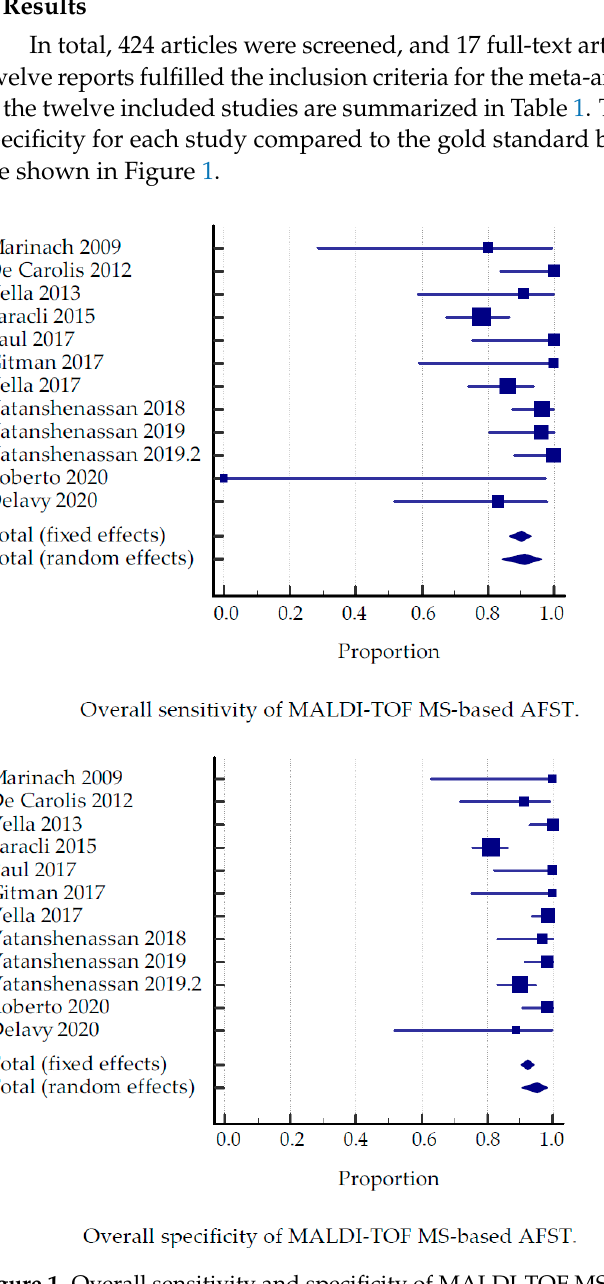
Figure 1. Overall sensitivity and specificity of MALDI-TOF MS-based AFST compared to the gold standard of broth dilution (CLSI or EUCAST).